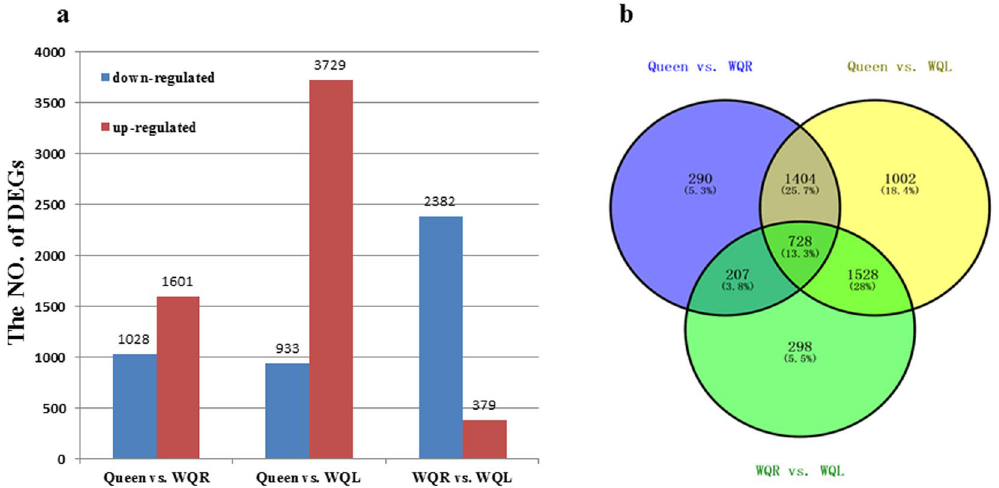
Figure 2. The DEGs among the three libraries. ( a ) Histogram of the DEGs from the three libraries. In each comparison ( a vs. b ), upregulated means that these genes were highly expressed in the latter group, ( b ) while downregulated means that genes were highly expressed in the former ( a ). ( b ) Venn diagram of the DEGs among the three